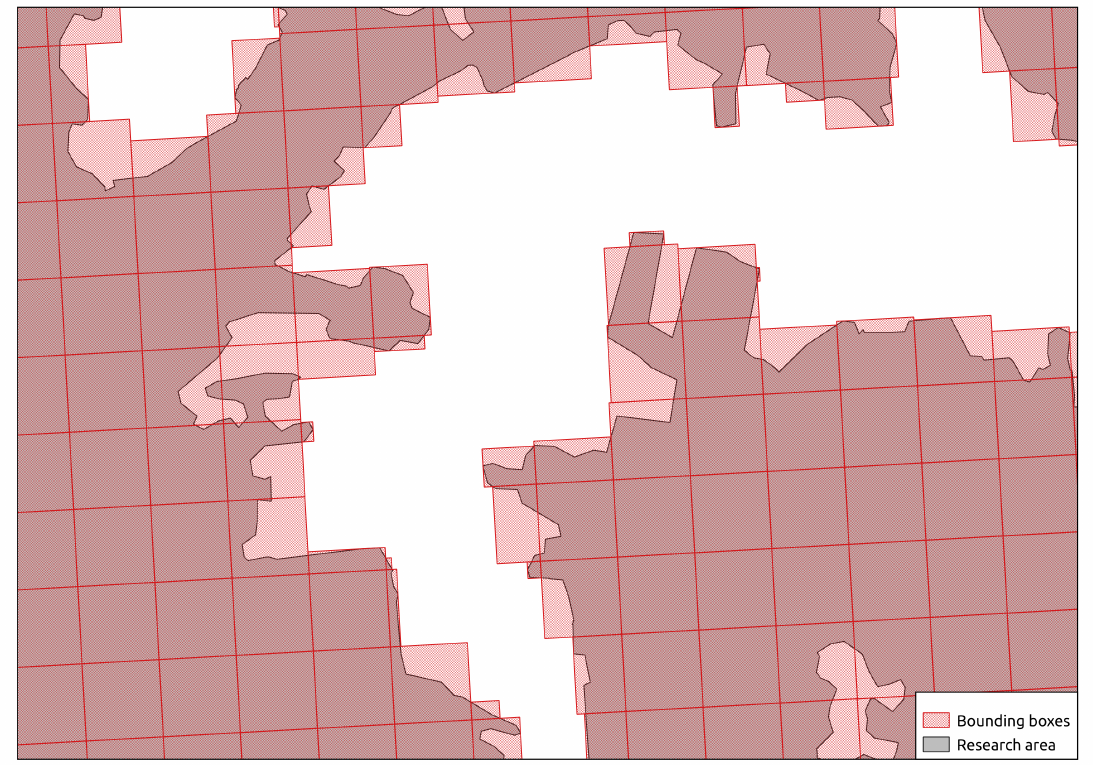
Figure 3. Sample portion of a research area. Bounding boxes are superimposed over their respective grid